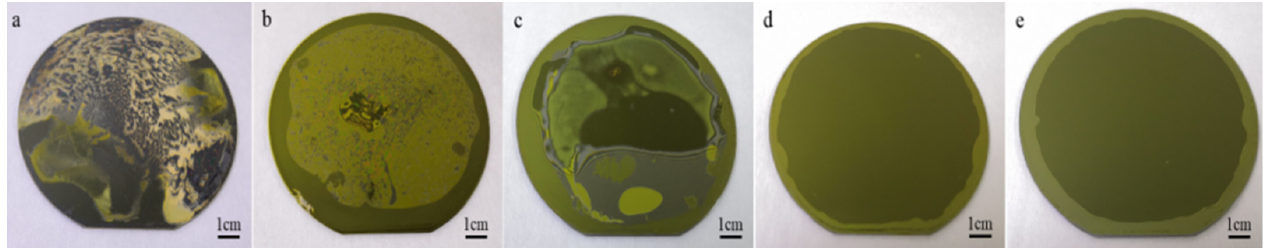
Figure 4. Optical images of glass/Si bonded pairs after pre-baking at ( a ) 80 °C, 1 min; ( b ) 80 °C, 30 min; ( c ) 80 °C, 30 min; 150 °C, 30 min; ( d ) 80 °C, 30 min; 150 °C, 30 min; 250 °C, 30 min; ( e ) 80 °C, 30 min; 150°C, 30 min; 250 °C, 30 min.